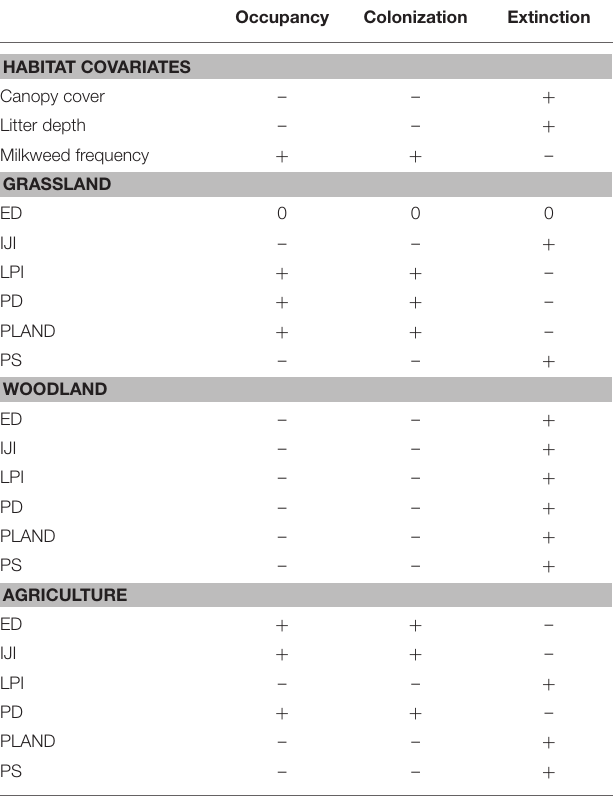
TABLE 2 | Number of properties, number of butterfly surveys, and frequency of each with monarchs, Iowa, 2006–2017. Year Properties a Surveys Percent of